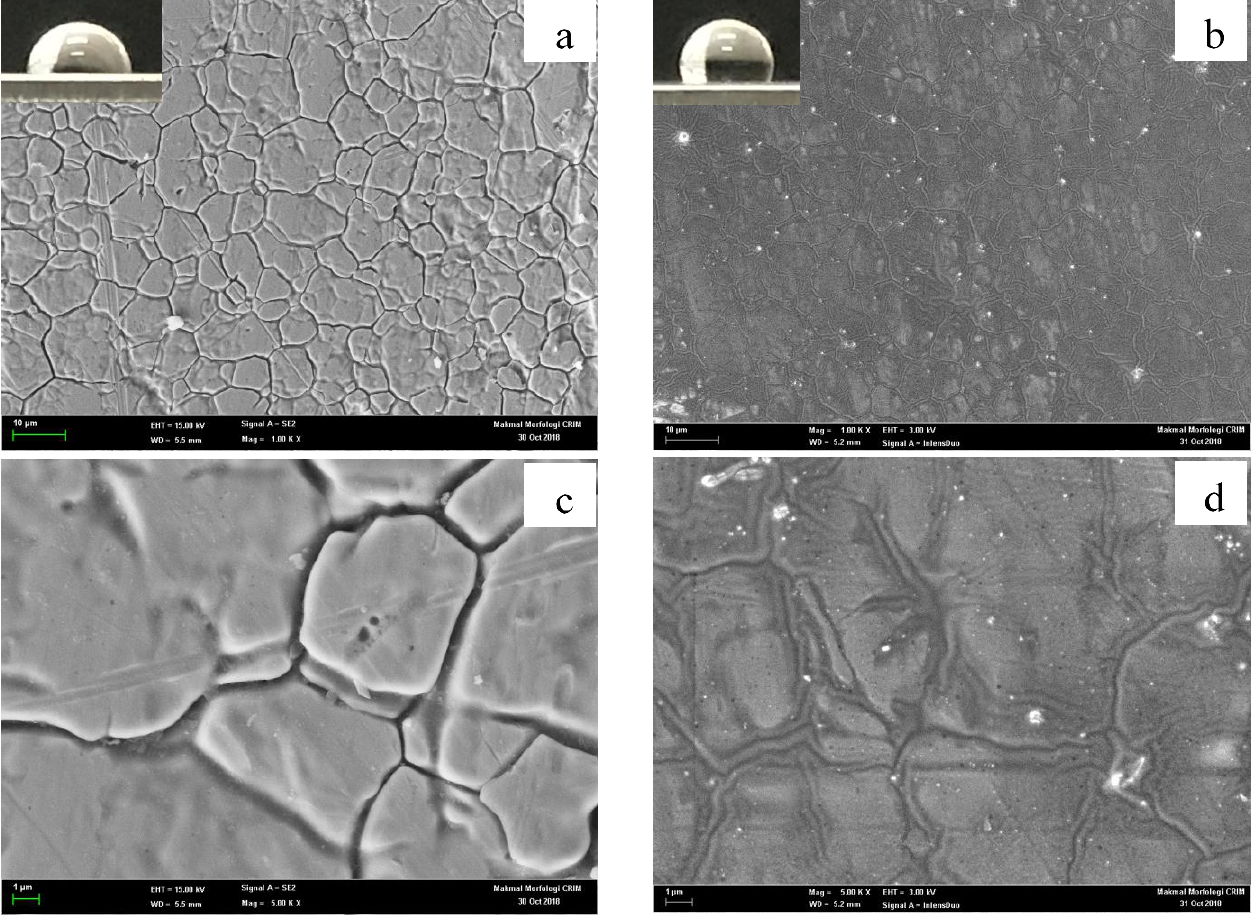
Figure 6. Surface morphology of the stainless steel substrates under ( a , c ) untreated conditions and ( b , d ) PDMS-treated conditions at different magnifications: ( a , b ) at 1000× magnification and ( c , d ) at 5000× magnification.